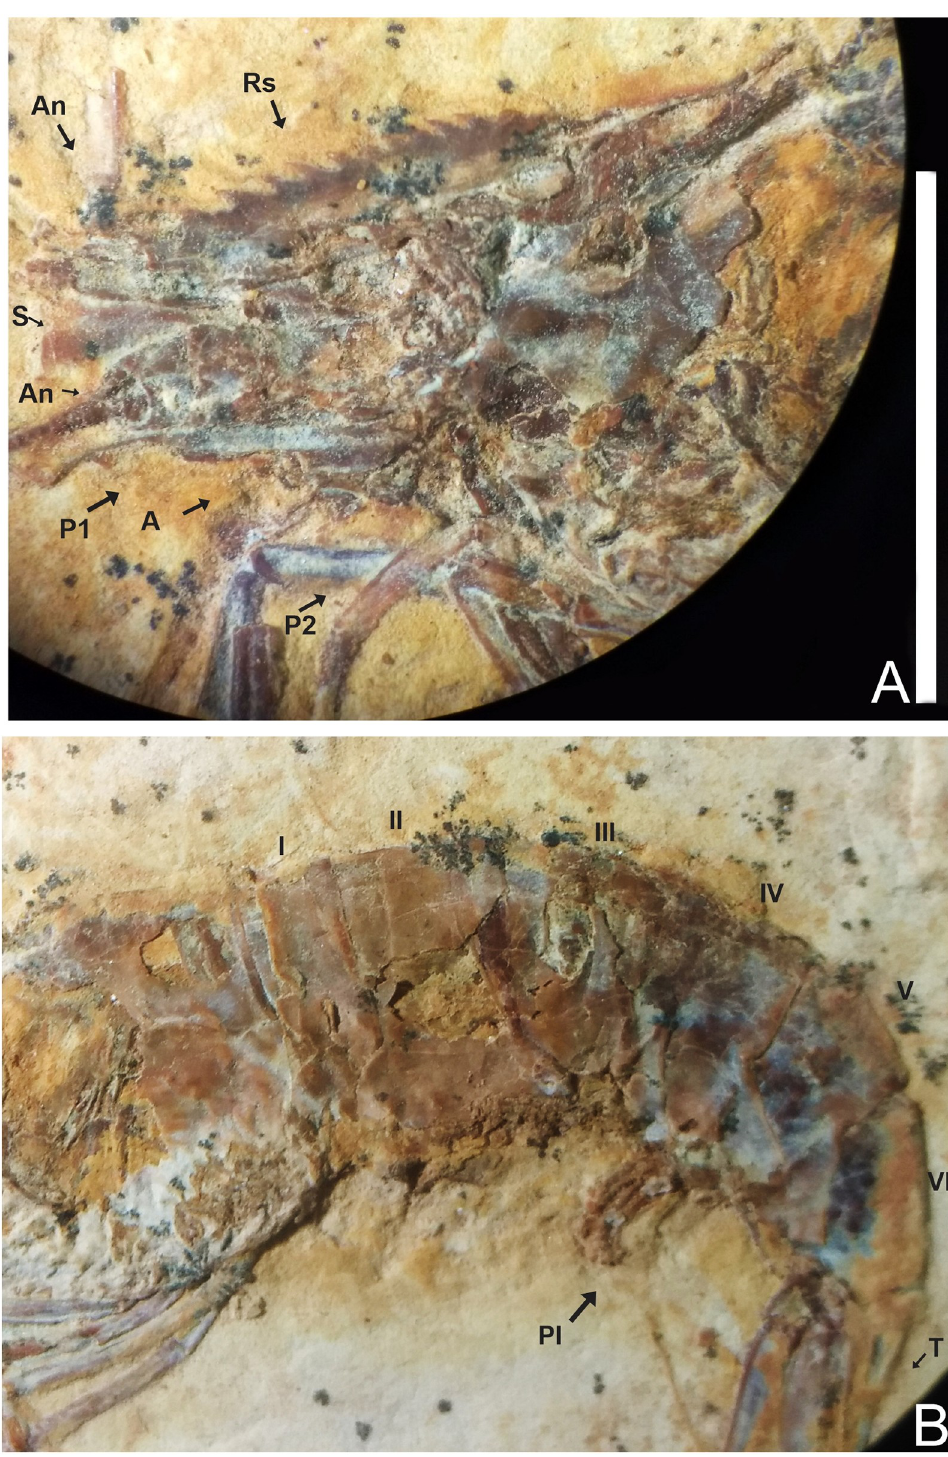
Fig 14. UFRJ 243/CR. A) Detail of the rostrum with exhibits 11 supra-rostral spines with serrate appearance, sub-rostral spines not discernible. Rs = rostrum, A = antenna, An = antennule, S = scaphocerite, P1, P2 = pereiopods. B) The pleura of the second somite is strongly rounded, overlapping the first and third. The fourth and fifth somites are with a strongly acute pleura, characteristic that typical of Beurlenia araripensis . Rs: Rostrum; A: Antenna; An: Antennule; S: Scaphocerite; P1, P2: Pereiopods; I-VI: Pleon; Pl: Pleopods; T: Telson. Scale bar: 10 mm. Photo by Olga A. Barros.